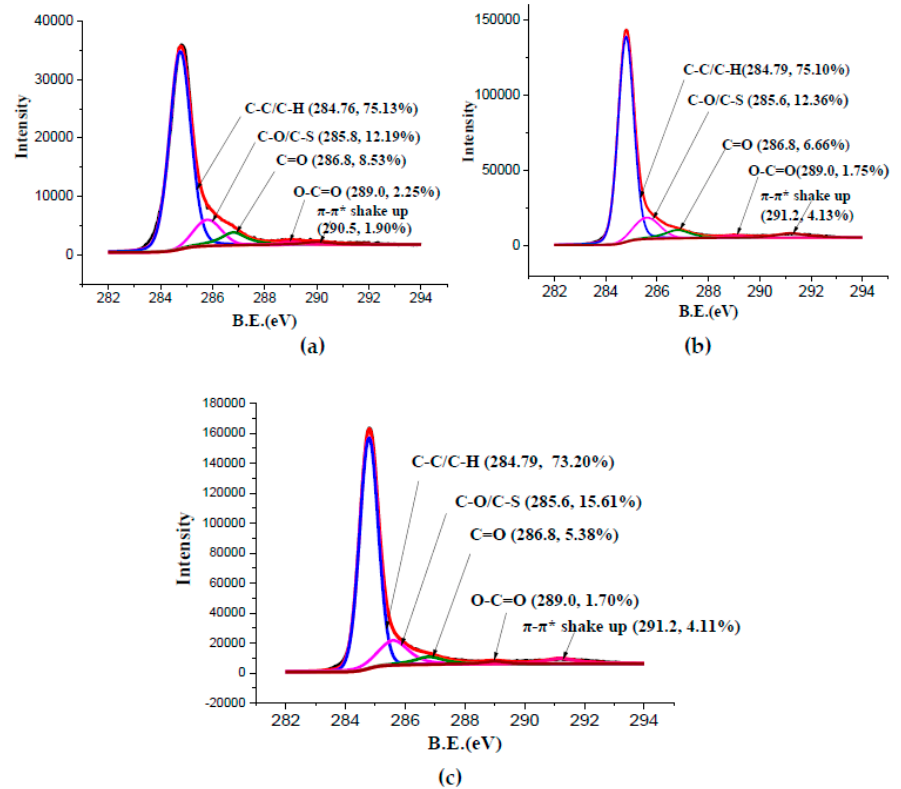
Figure 2. X-ray photoelectron spectroscopy (XPS) survey (C1s scan) of ( a ) EG1, ( b ) EG2, and ( c ) EG3.